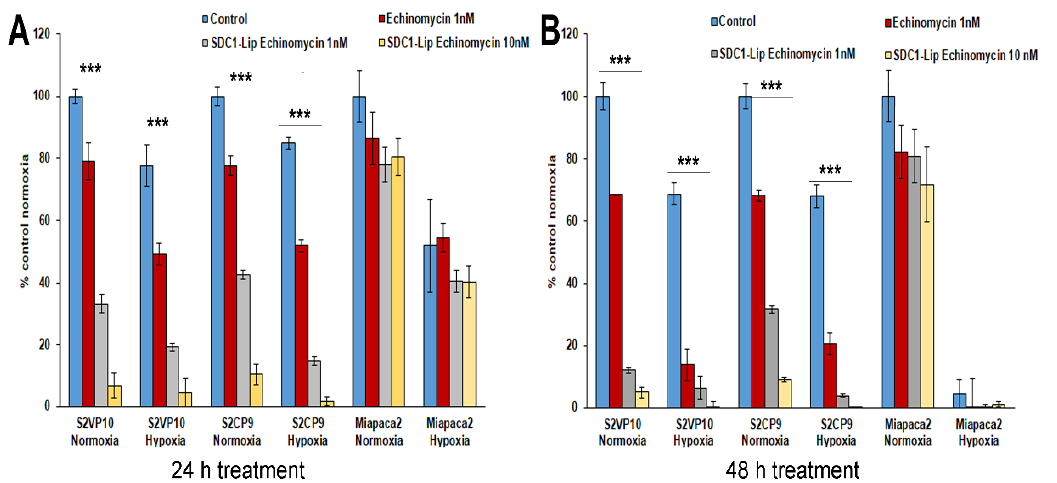
Figure 2. Treatment of pancreatic cancer cells with SDC1-Lip echinomycin under normoxic